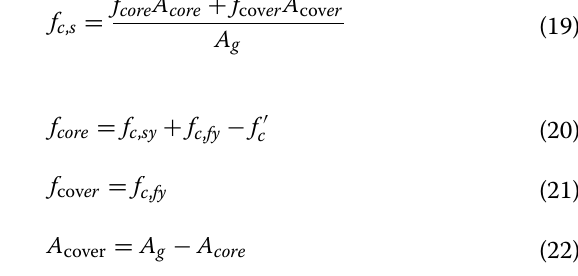
relationships for the unwrapped column and columns having the same CFRP volumetric ratio, ρ f a ρ f